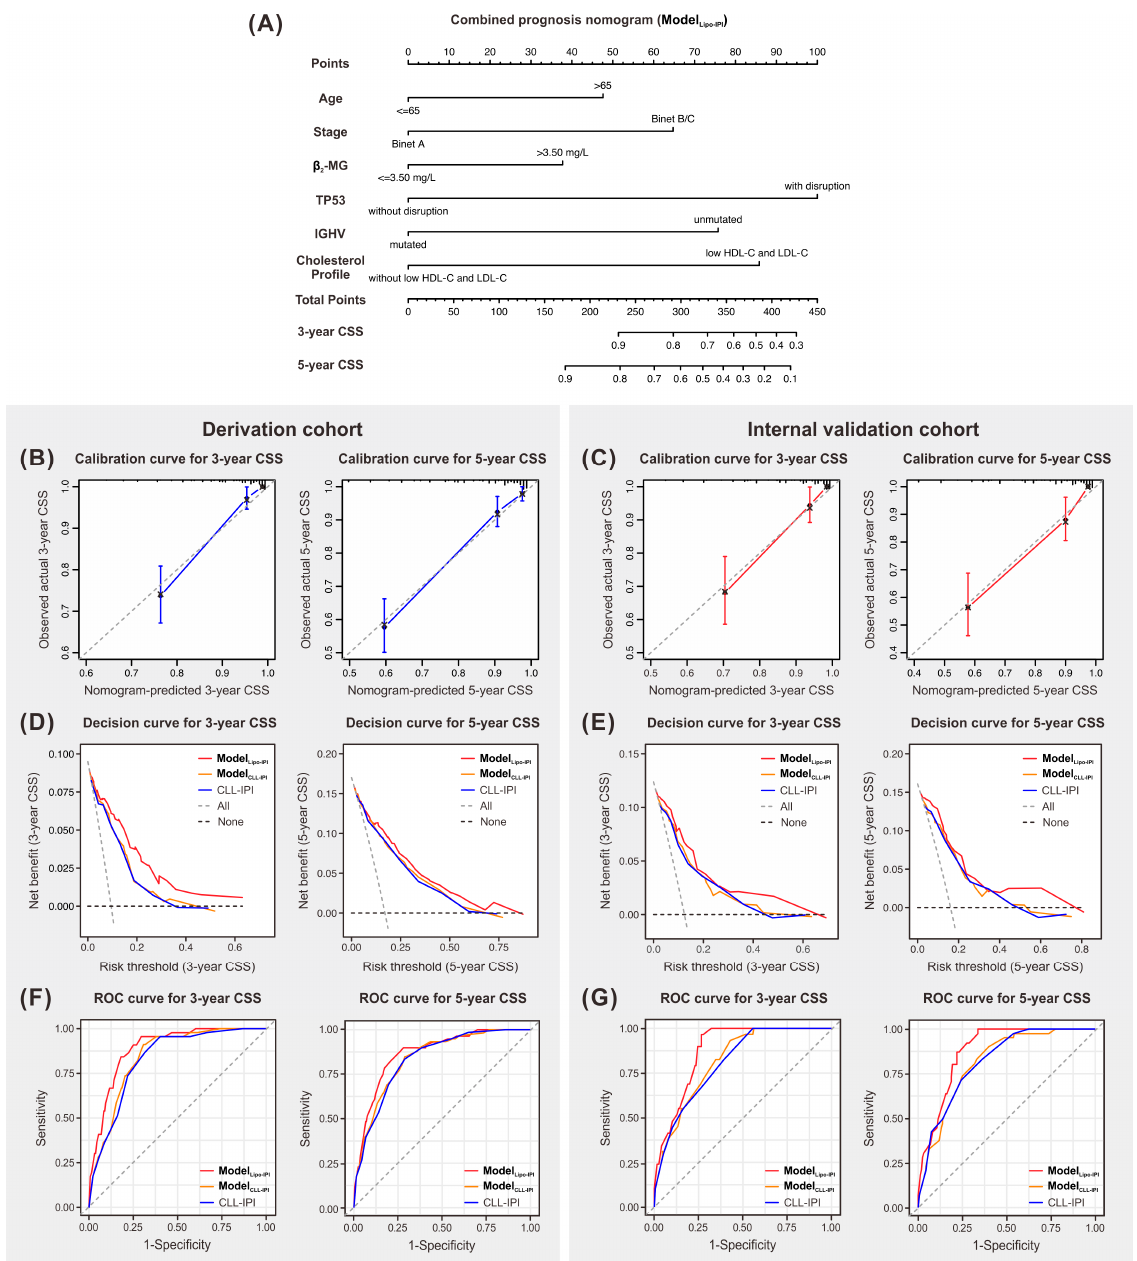
Figure 3. Nomogram and prognostic performance of Model Lipo-IPI for cancer-specific survival (CSS). ( A ) A combined prognostic nomogram Model Lipo-IPI for predicting CSS in CLL patients, including age, stage, β 2 -microglobulin ( β 2 -MG) level, TP53 , immunoglobulin heavy chain variable region ( IGHV ) status, and cholesterol profile as factors. ( B , C ) Calibration curves of Model Lipo-IPI for predicting 3-year and 5-year CSS in the derivation ( B ) and internal validation ( C ) cohorts. ( D , E ) Decision curve analyses of different models for predicting 3-year and 5-year CSS in the derivation ( D ) and internal validation ( E ) cohorts. ( F , G ) Receiver operating characteristic (ROC) curves of different models for predicting 3-year and 5-year CSS in the derivation ( F ) and internal validation ( G ) cohorts. Abbreviations: HDL-C, high-density lipoprotein cholesterol; LDL-C, low-density lipoprotein cholesterol; CLL-IPI, international prognostic index for chronic lymphocytic